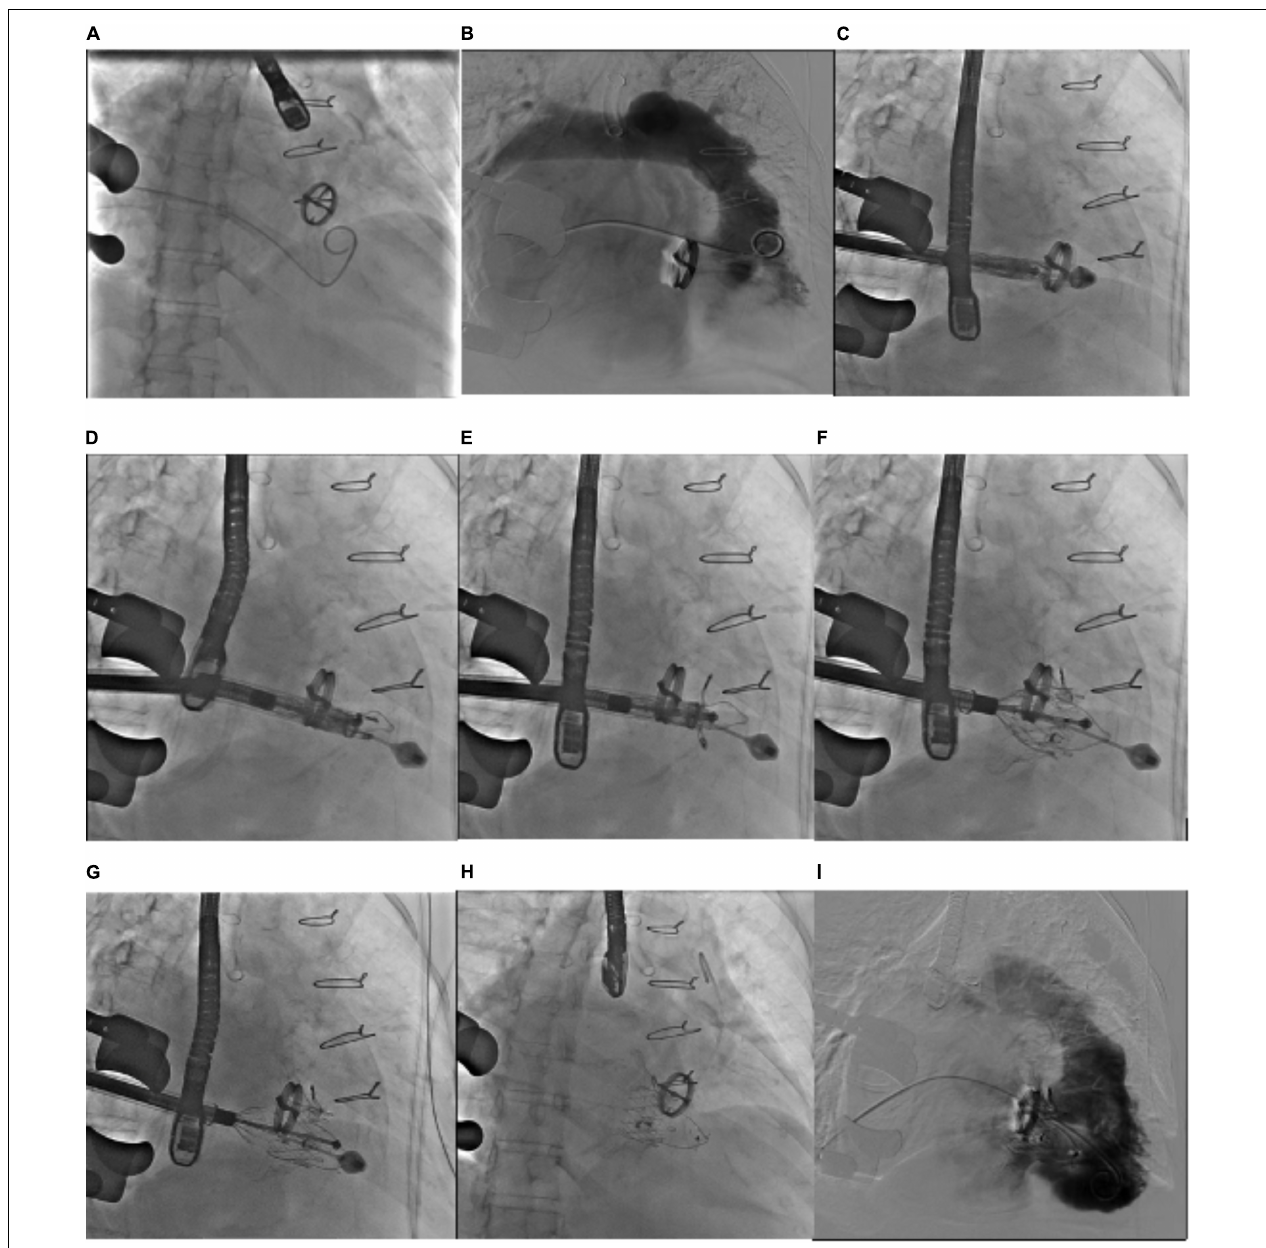
FIGURE 1 | TTVI procedure: After a small (5–8 cm) intercostal incision was made in the fourth intercostal space on the right side of the chest, the location of the right atrium was identified by transesophageal echocardiography and fluoroscopy (A) . Digital subtraction angiography (DSA) was used to reveal the contrast medium flow between the right atrium and ventricle. (B) Shows the back flow of contrast medium from the right ventricle into the right atrium before LuX-valve implantation. Under DSA and transthoracic echocardiogram guidance, the valve was loaded into the delivery system and passed through the tricuspid orifice toward the right ventricular cavity (C) . Interventricular anchorage, parallel to the septum was assured (D) . The anterior valve hook-and-jaw device was gradually released and hooked onto the anterior valve leaflet, after the valve position was determined (E) . The atrial facet umbrella disc was released (F) . Transthoracic echocardiogram confirmed the position of umbrella disc in the annulus and atrial wall tissue, and ensured there was no obvious paravalvular leakage (G) . The valve was finally released when the septal anchoring device was in position (H) . After LuX-valve implantation, DSA showed satisfactory right ventricular filling with no or minimal, contrast medium back-flow (I)